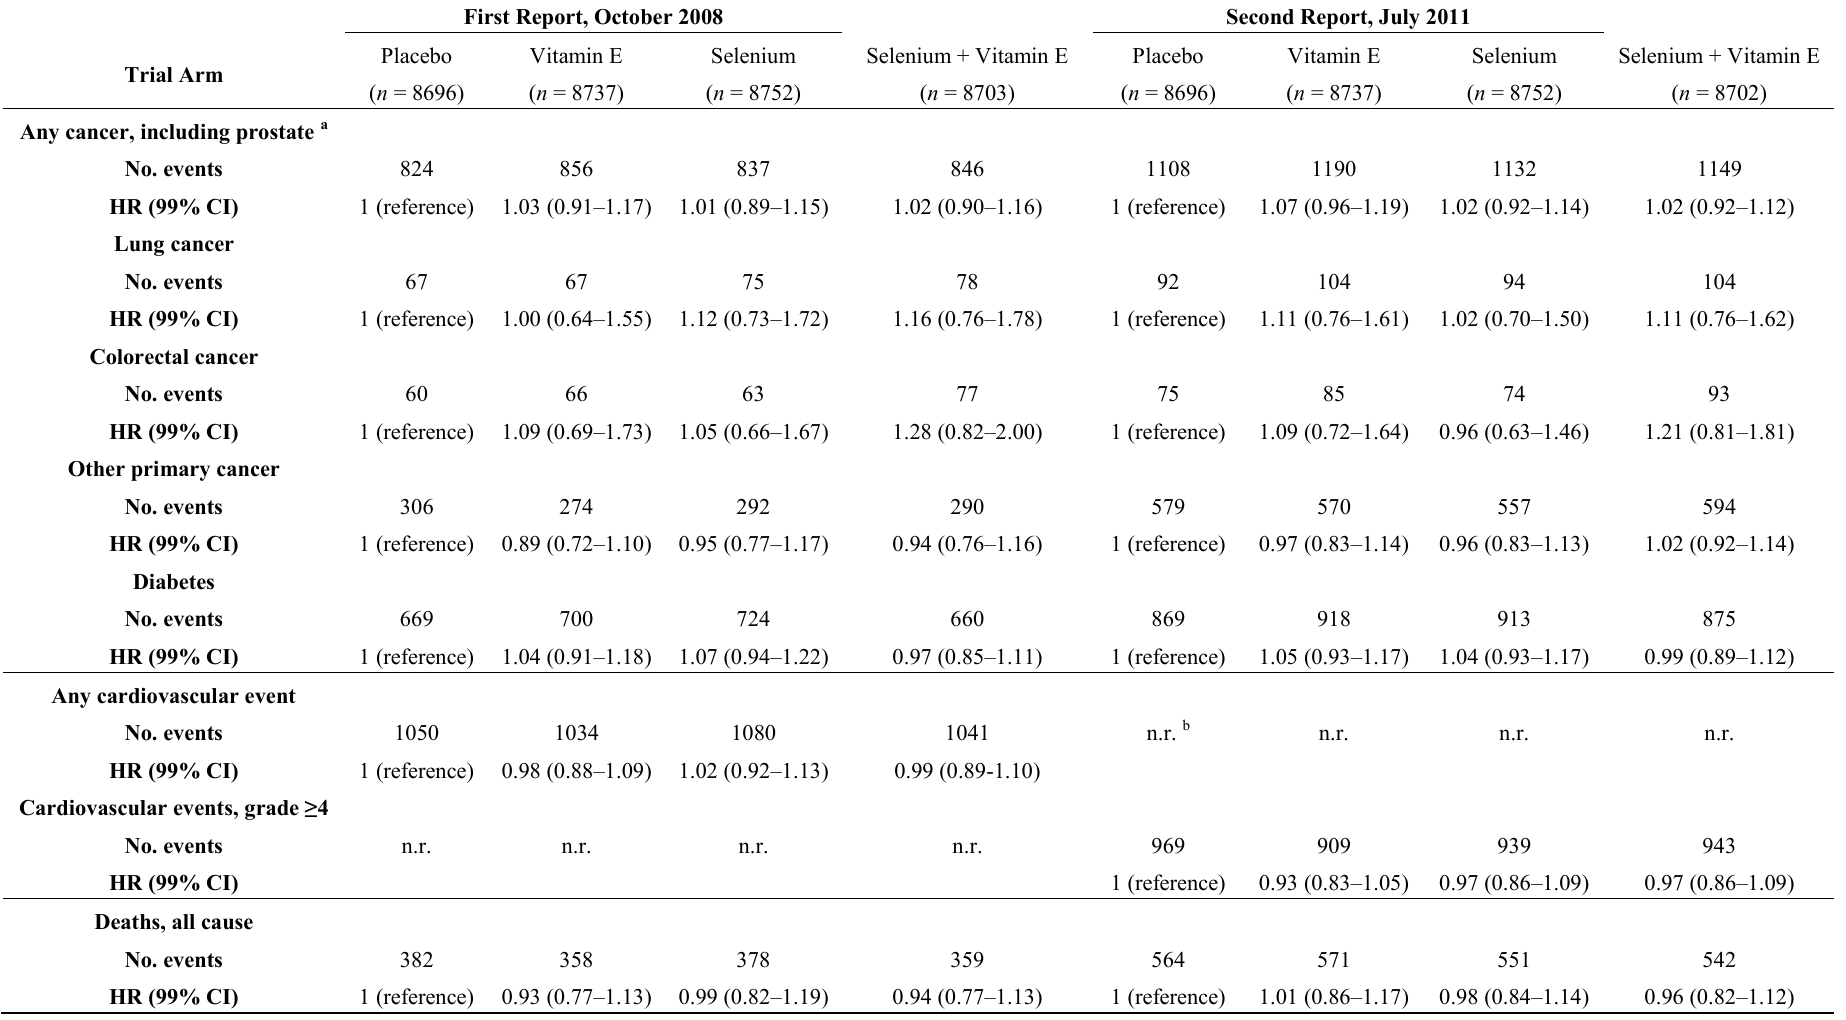
Table 3. Secondary endpoints and adverse outcomes in SELECT by report date